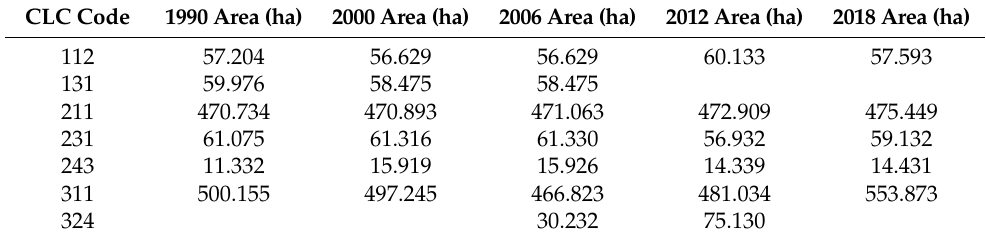
Table 5. Representation of each CLC class for the selected period.